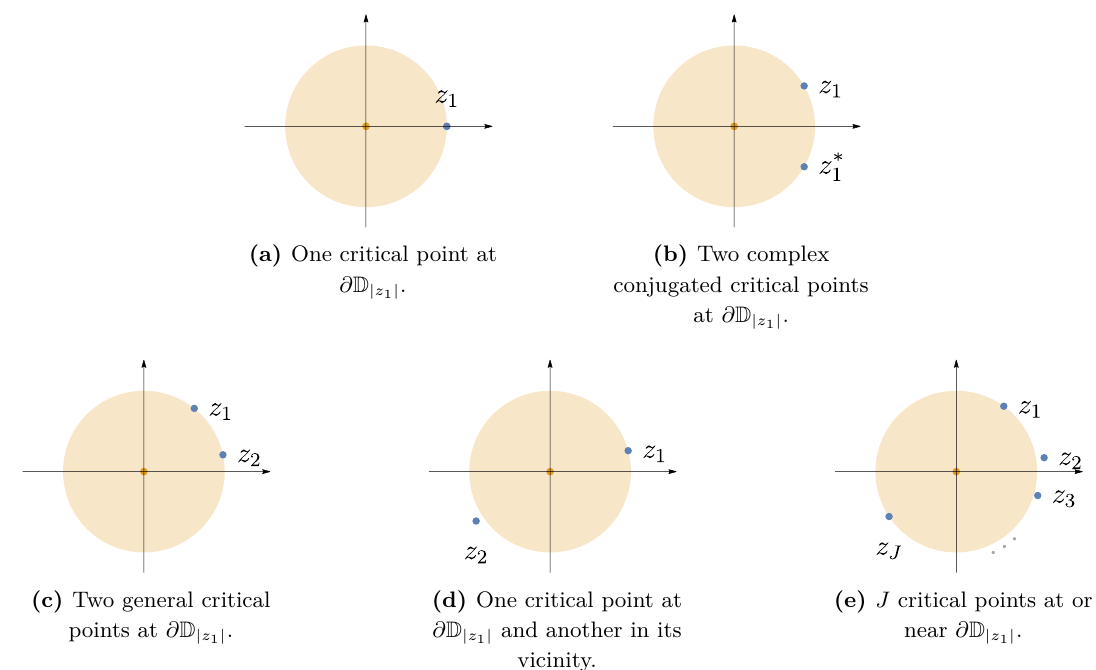
Figure 1. Different configurations of critical (branch) points limiting